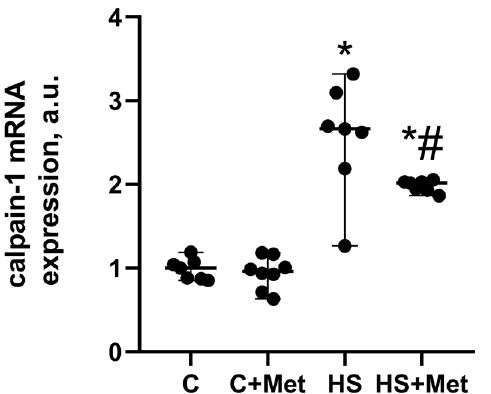
Figure 9. Effect of metformin pre-treatment on calpain-1 mRNA expression in rat soleus. C, vivar- ium control, C+Met, vivarium control + metformin pre-treatment, HS, 7-day hindlimb suspension, HS+Met, metformin pre-treatment + 7-day hindlimb suspension. Scatter dot plot indicates median values, and the whiskers represent minimum and maximum values; n = 7–8/group. *: p < 0.05 vs. C, #: p < 0.05 vs. HS.